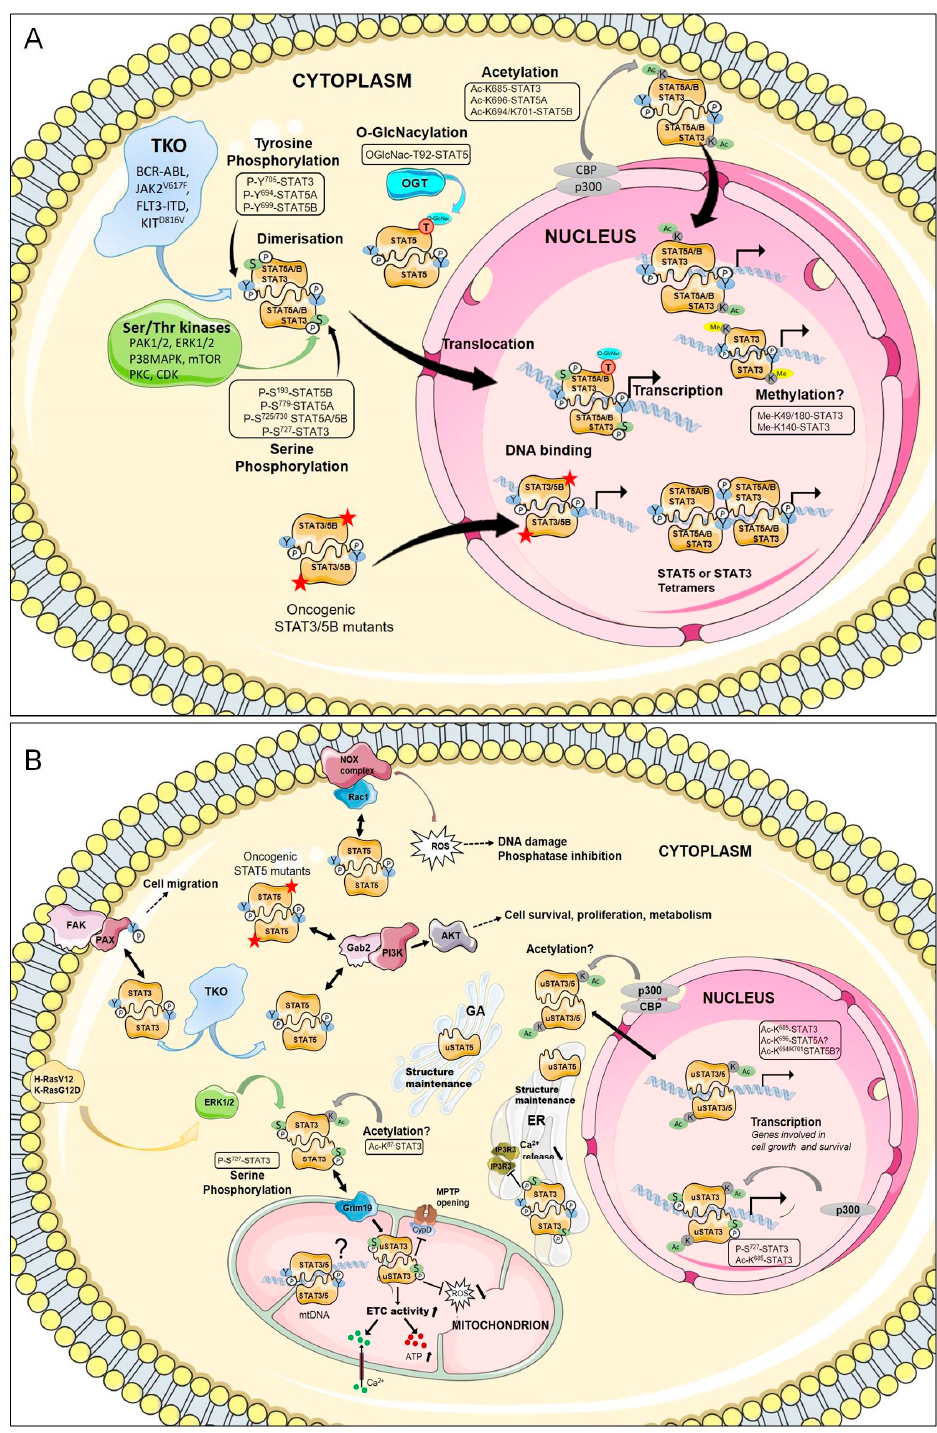
Figure 3. STAT3 and STAT5 signaling in hematologic malignancies. ( A ) Canonical function. In the canonical model, TKOs, or GOF mutations induce persistent activation (e.g., tyrosine phosphorylation) and nuclear translocation of STAT3 and STAT5, which then bind as dimers or tetramers to specific promoter sequences to regulate transcription of genes involved in cell growth, apoptosis, angiogenesis and immune response. Other post-translational modifications, as indicated, regulate the oncogenic activity of STAT3 / STAT5. OGT (O-GlcNAc transferase). ( B ) Non-canonical function. uSTAT3 and uSTAT5 (non-tyrosine phosphorylated STAT3 / 5) proteins also have an active role in the nucleus, mitochondrion, ER (endoplasmic reticulum), GA (golgi apparatus), ETC (electron transport chain). Besides their transcriptional activity, P-Y-STAT3 and P-Y-STAT5 interact with di ff erent signaling pathways in the cytoplasm and